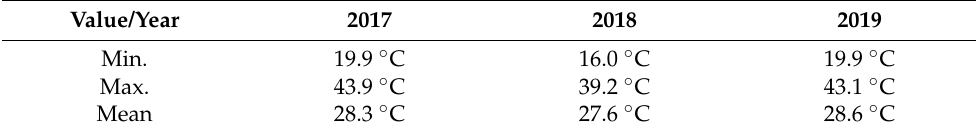
Table 1. Basic LST statistics for the area of Wroclaw